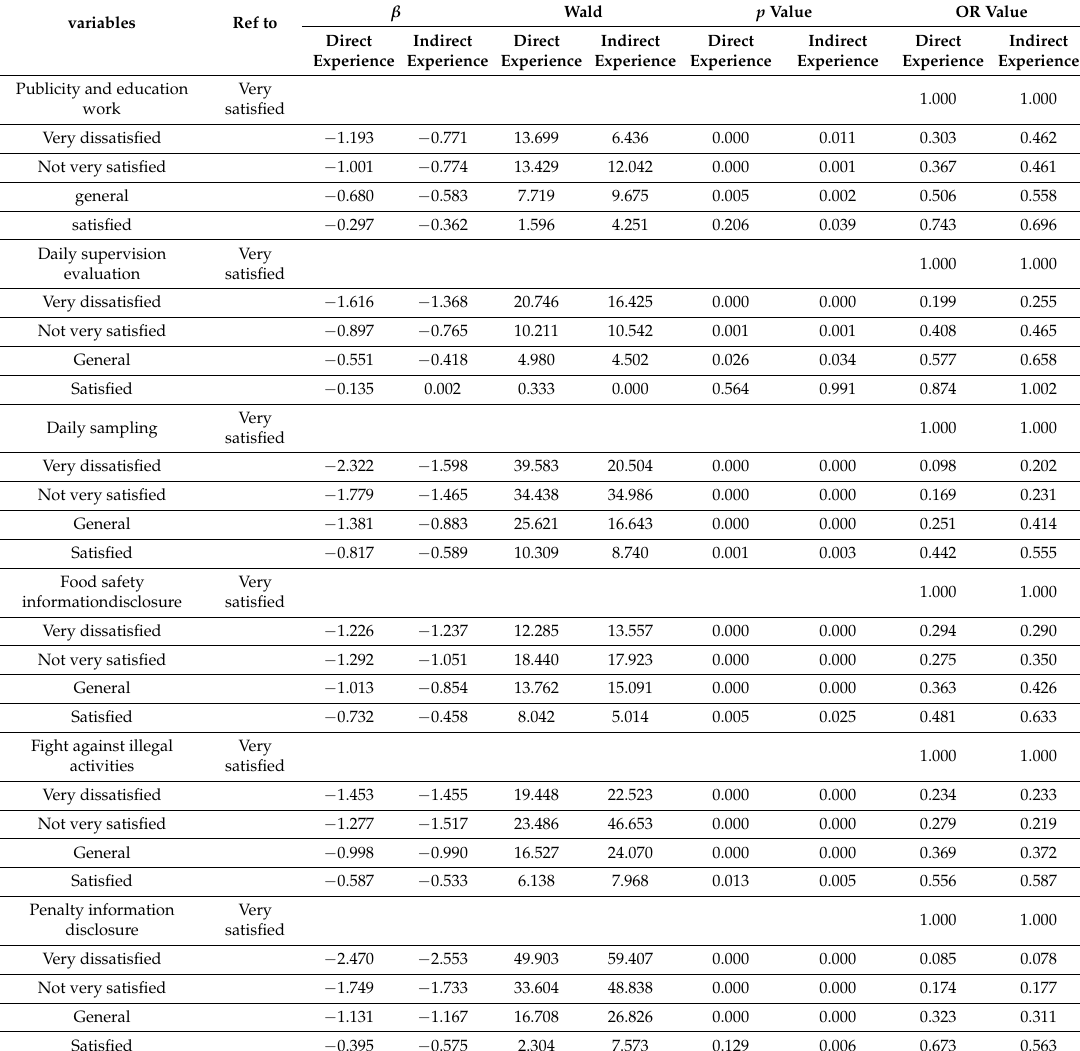
Table 5. Two types of consumer supervision evaluation model parameter estimation